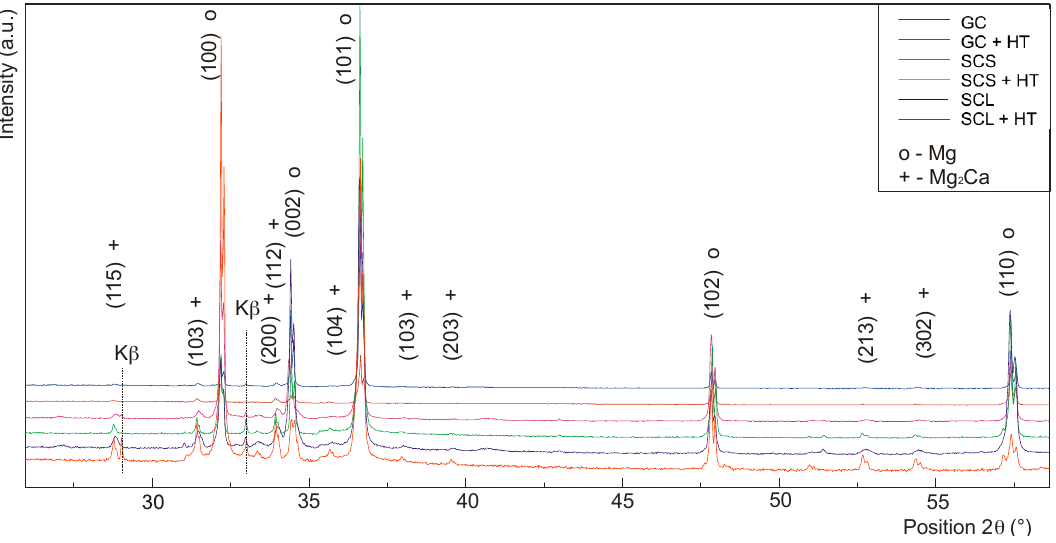
Figure 5. X-ray pattern of Mg-3Zn-2Ca magnesium alloy processed by different methods.